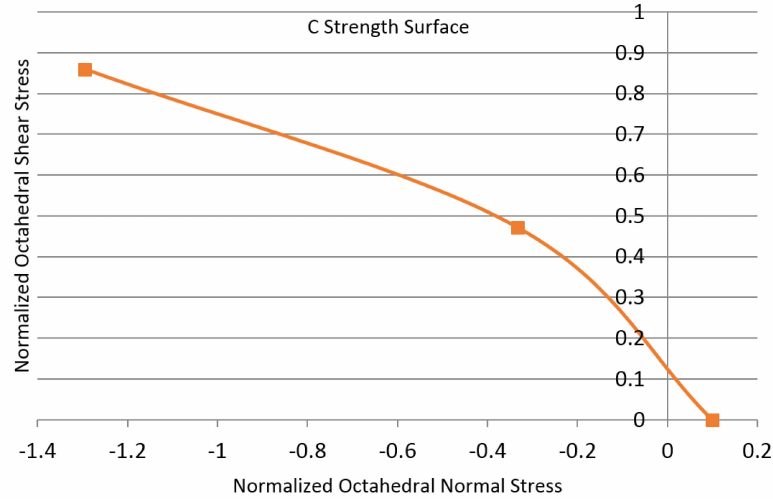
Figure 8. Upadted C strength surface obtained after